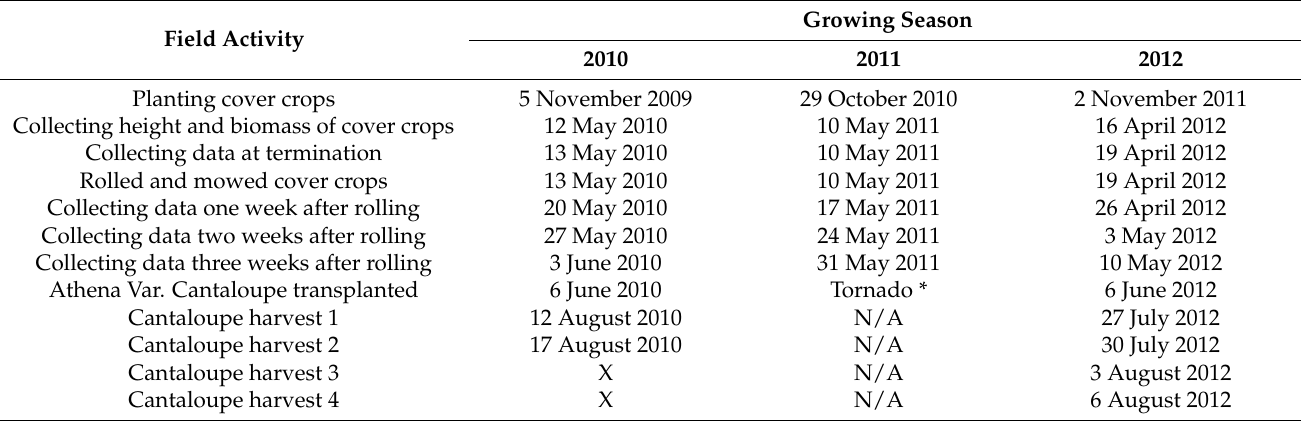
Table 1. Field activities at each growing season.